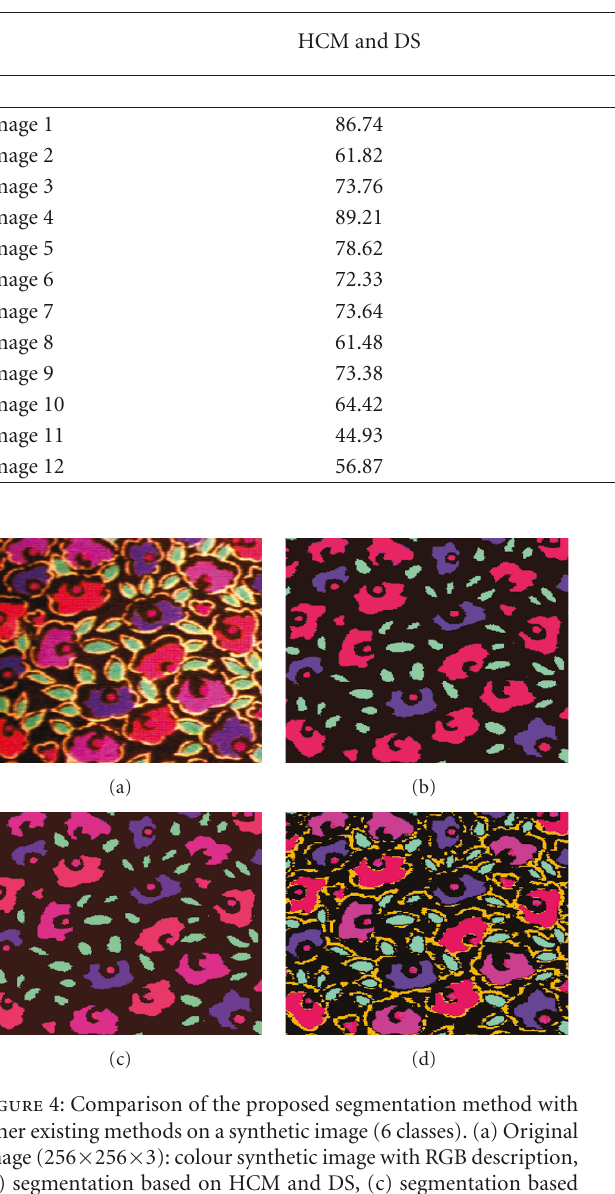
Figure 5: Data set used in the experiment. Twelve were selected for a comparison study. The patterns are numbered from 1 through 12, starting at the upper left-hand